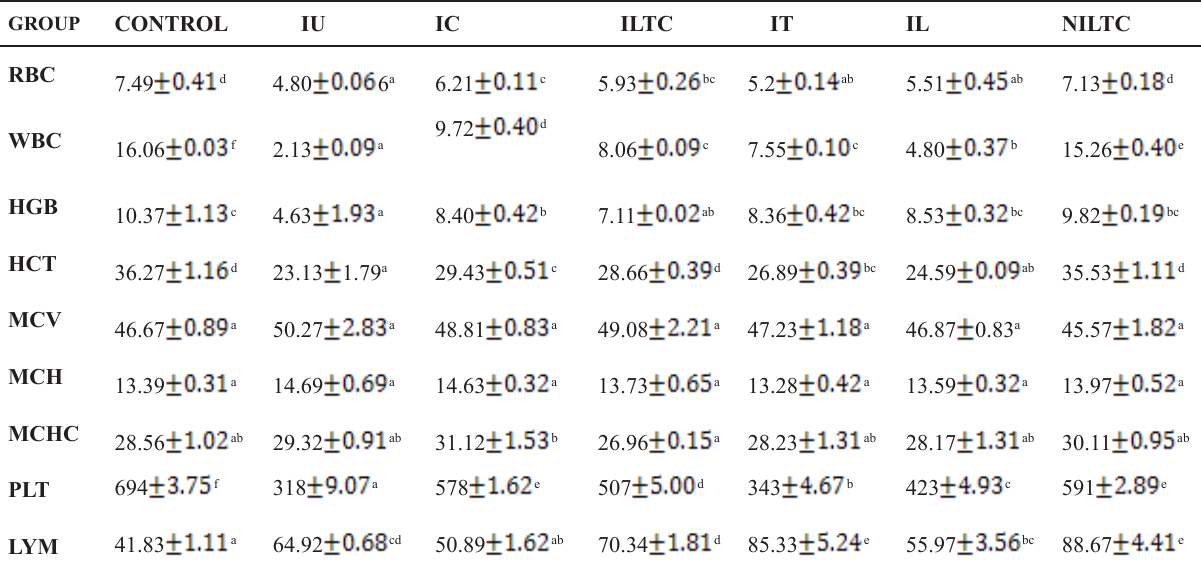
Table 4: Effects of lumefantrine, trimethoprim and lumefantrine-trimethoprim-copper complex on haematological parameters in P. berghei NK-65 infected and non-infected